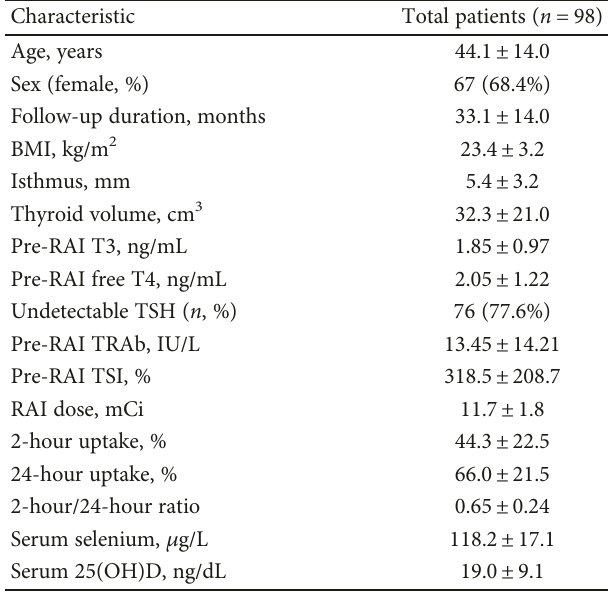
Table 1: Baseline clinical characteristics of patients with Graves ’